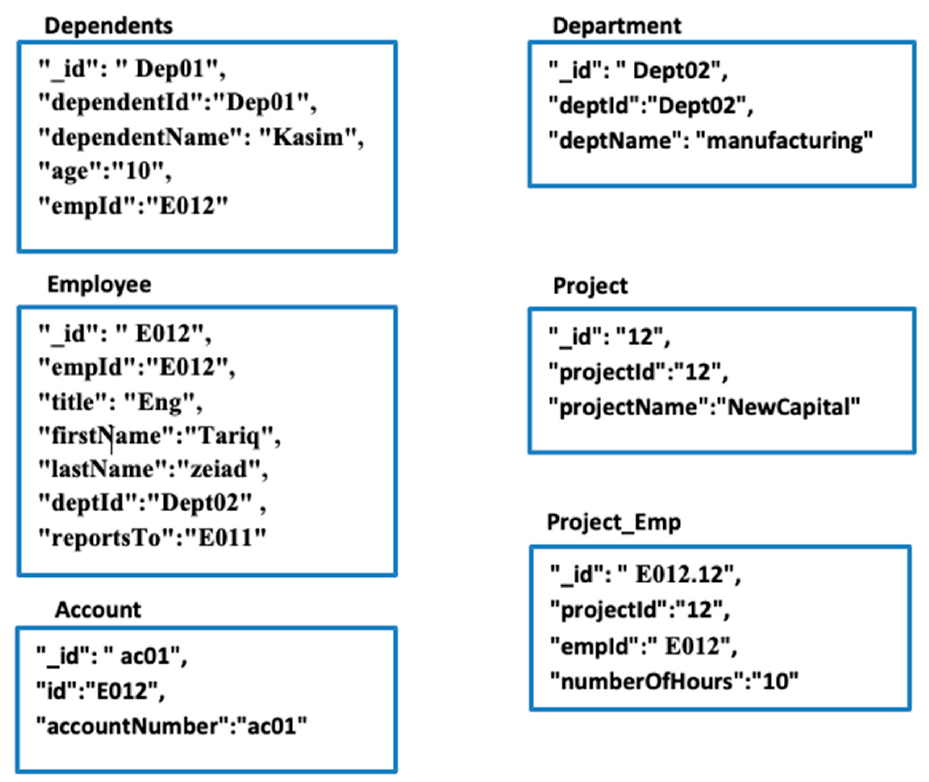
Figure 3. Document schema generated by applying rules 2, 5 and 8 to Figure 2. Algorithm 2: Transformation and Migration from RDB to Column